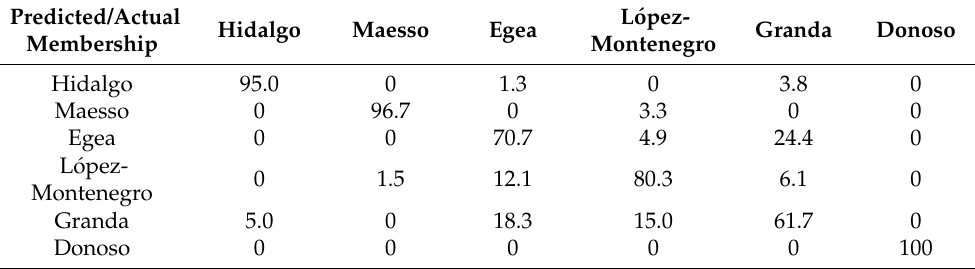
Table 7. Discriminant analysis: percentage of animals correctly classified in their historical genetic lines.